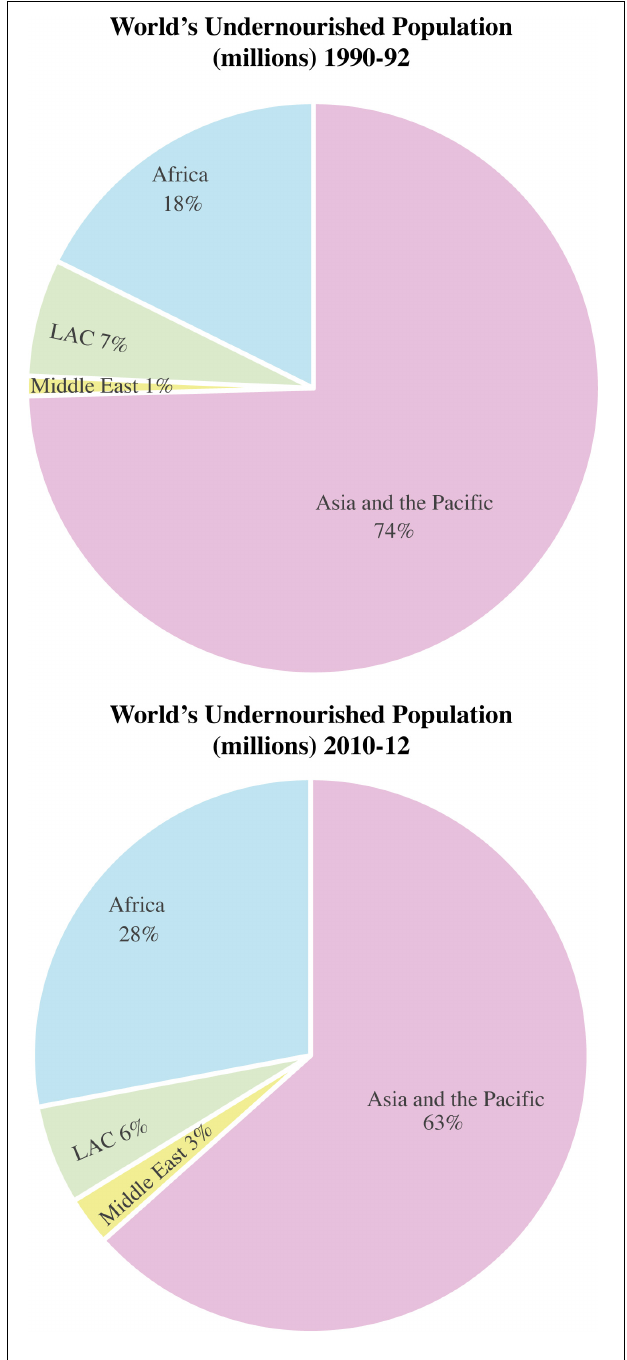
FIGURE 2 | World’s undernourished population (The undernourished are those with a caloric intake less than the minimum daily requirement; LAC, Latin America and the Caribbean; Source: ADB calculations based on economy-level estimates from the FAO Food Security Indicators), http://www.fao.org/economic/ess/ess-fs/ess-fadata/en/.